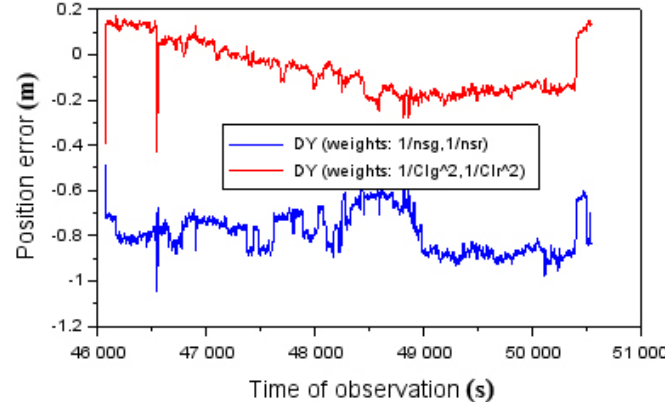
Figure 14. Position errors along the Y -axis .